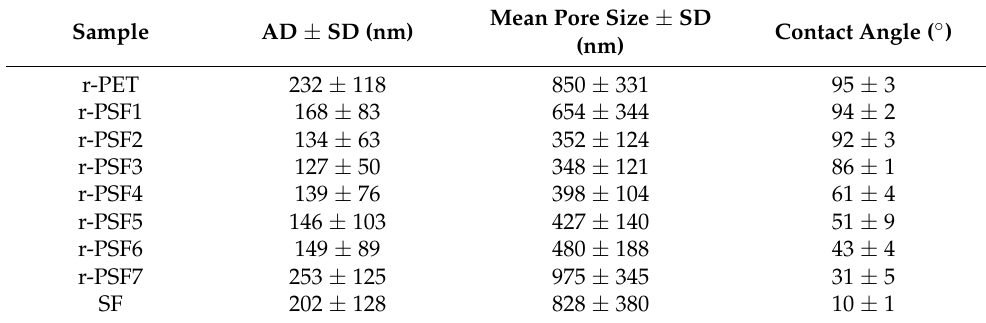
Table 2. List of average diameters (AD), the mean pore size of the fibers in the mats, and contact angles of all investigated electrospun